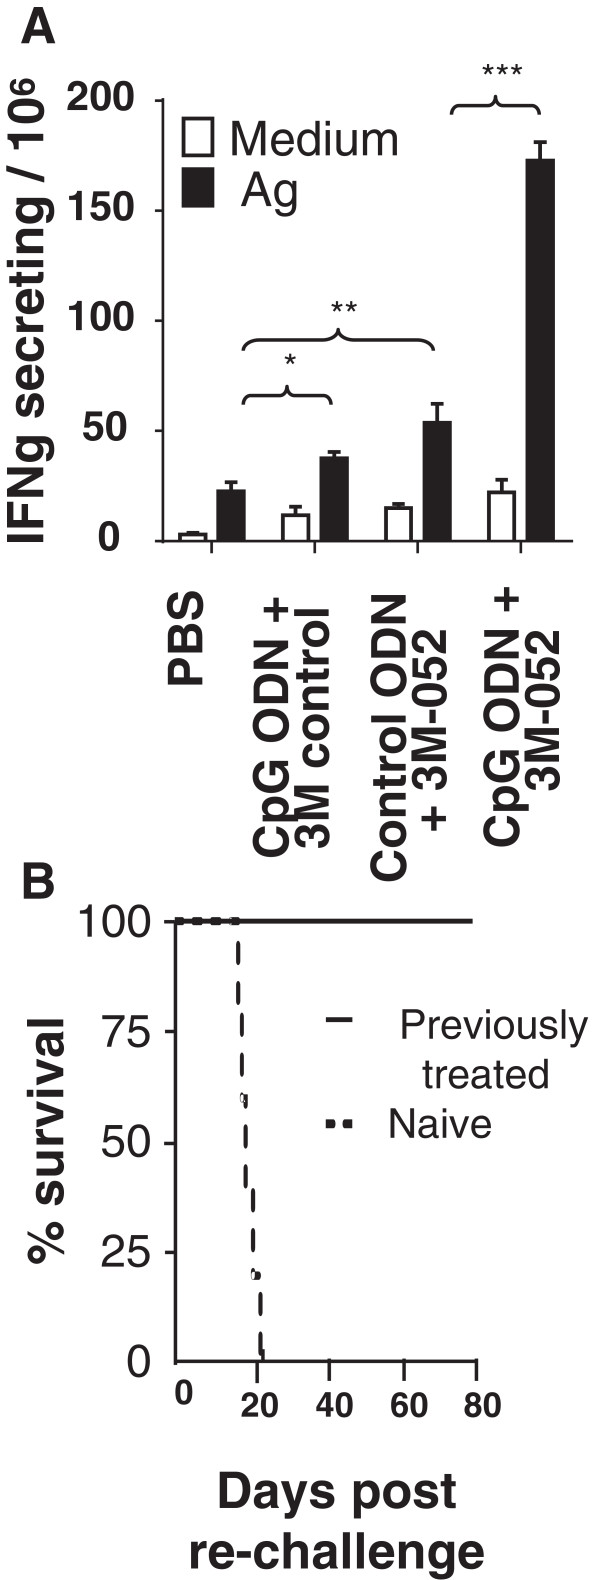
TLR agonist therapy induces persistent immunity. 105 CT26 cells were implanted into the flank of syngeneic BALB/c mice. Large established tumors (≈800 mm3 in volume) were treated as described in Figure 
5. A) Cells from the tumor draining LN were isolated one day after the third treatment, stimulated ex vivo with AH-1 peptide, and monitored for IFNγ secretion by ELIspot assay. Results represent the mean + SD of 4 independently studied mice/group. B) Mice cured of their CT26 tumors by treatment with CpG ODN plus 3M-052 (a cure being defined as being free of detectable tumor for ≥2 months after the cessation of therapy) were re-challenged with 106 CT26 cells. Their survival compared to naive mice challenged with the same tumor dose is shown (N = 6 mice/group). *, p < 0.05; **, p <0.01, ***, p <0.001.